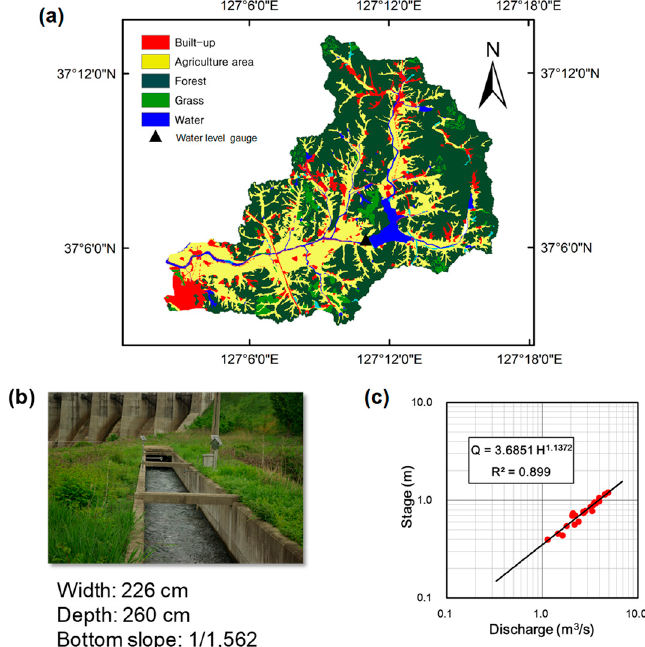
Figure 1. ( a ) Location of the Idong reservoir irrigated district, ( b ) the photo of the main irrigation canal, and ( c ) the stage–discharge relationship curve (modified from